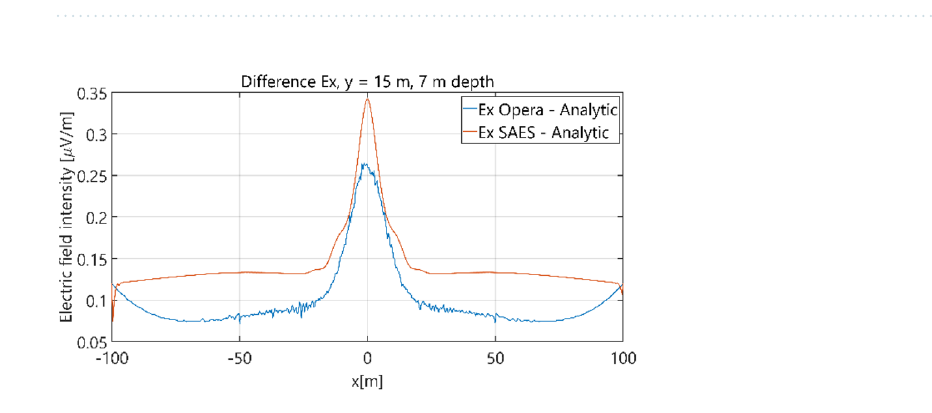
Figure 25. Distribution of differences between E x values obtained from Opera (FEM) and SAES (BEM) models and the analytical model ( y = 0 m, z = − 7 m, case II).